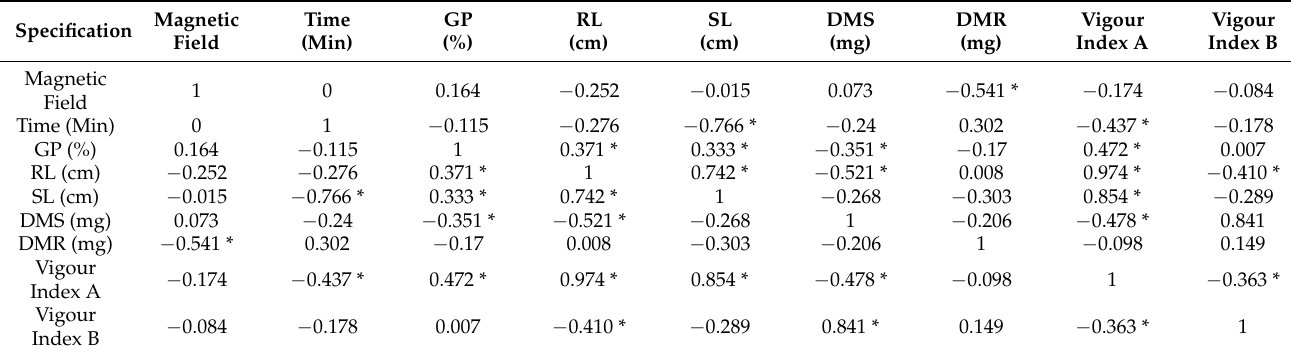
Table 3. Correlation analysis of the studied